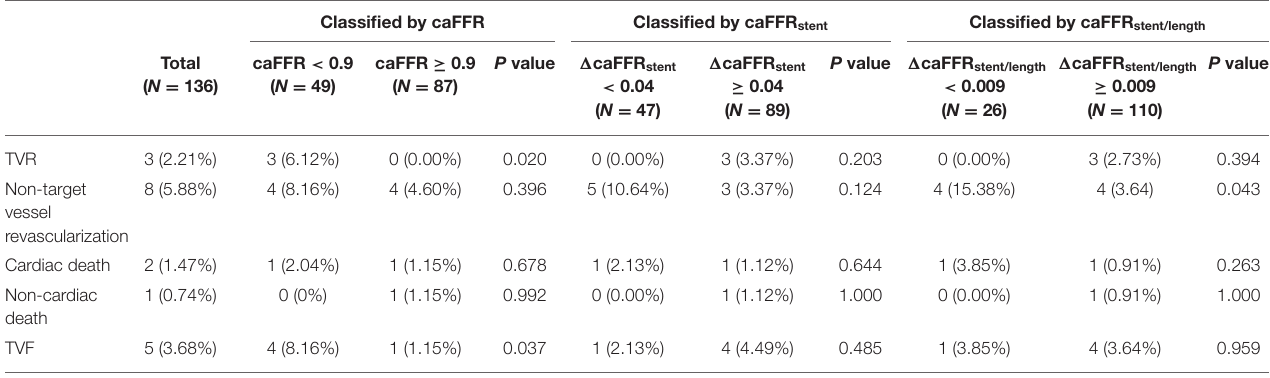
TABLE 4 | Clinical events at 9-month follow-up.